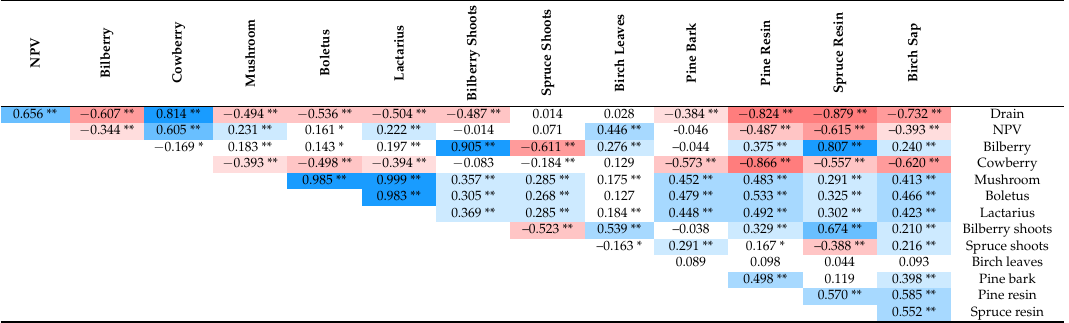
Positive correlations are displayed in blue (the four tones corresponding to correlations (0.8, 1), (0.6, 0.8), (0.4, 0.6) and (0.2, 0.4), respectively; darker colors denote stronger correlations) and negative correlations in a red color (the